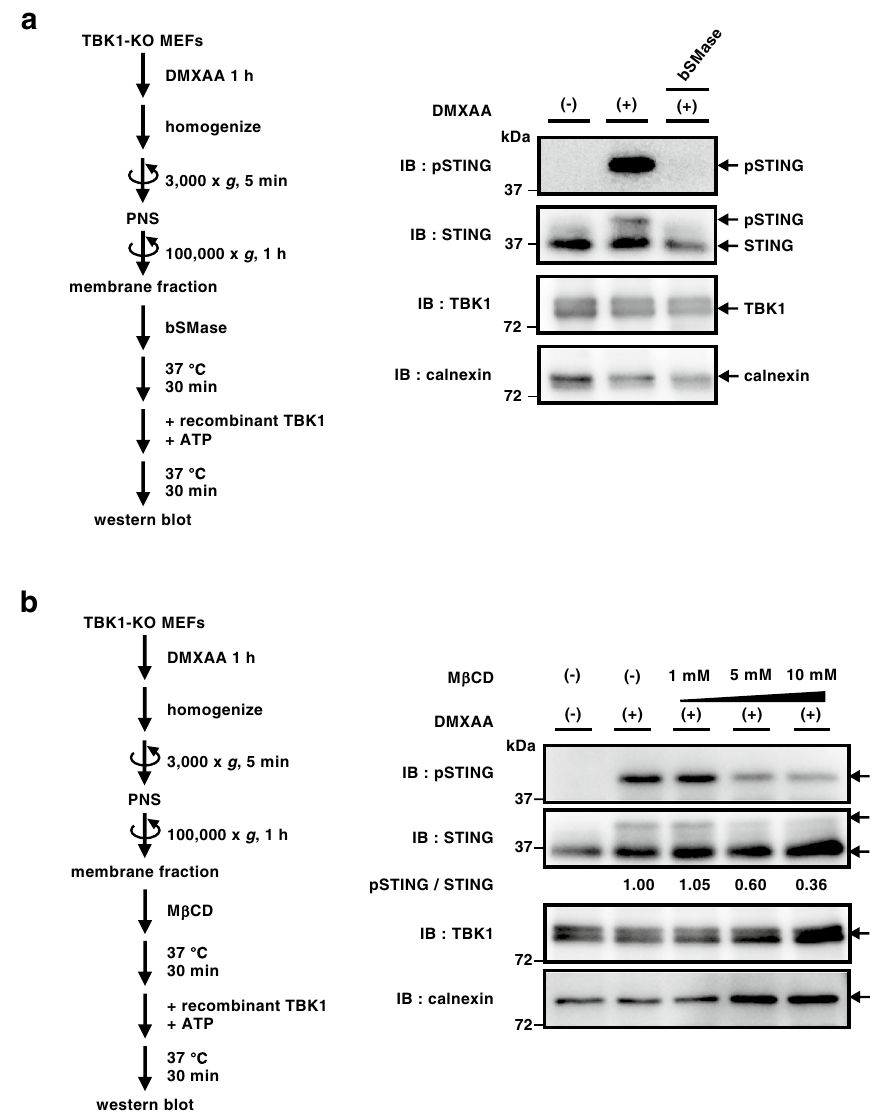
Figure 4. A role of cholesterol and sphingomyelin in STING phosphorylation in vitro. ( a , b ) The membrane fraction of TBK1-knockout MEFs that were stimulated with DMXAA for 1 h was collected by ultracentrifugation as in Fig. 2. The resuspended membrane fraction was incubated with recombinant bacterial sphingomyelinase (0.125 U/mL) ( a ) or methyl-β-cyclodextrin (MβCD) (1 mM, 5 mM, or 10 mM) at 37 °C for 30 min followed by incubation with recombinant TBK1 and ATP for 30 min. Phosphorylation of STING at Ser365 was then analyzed by western